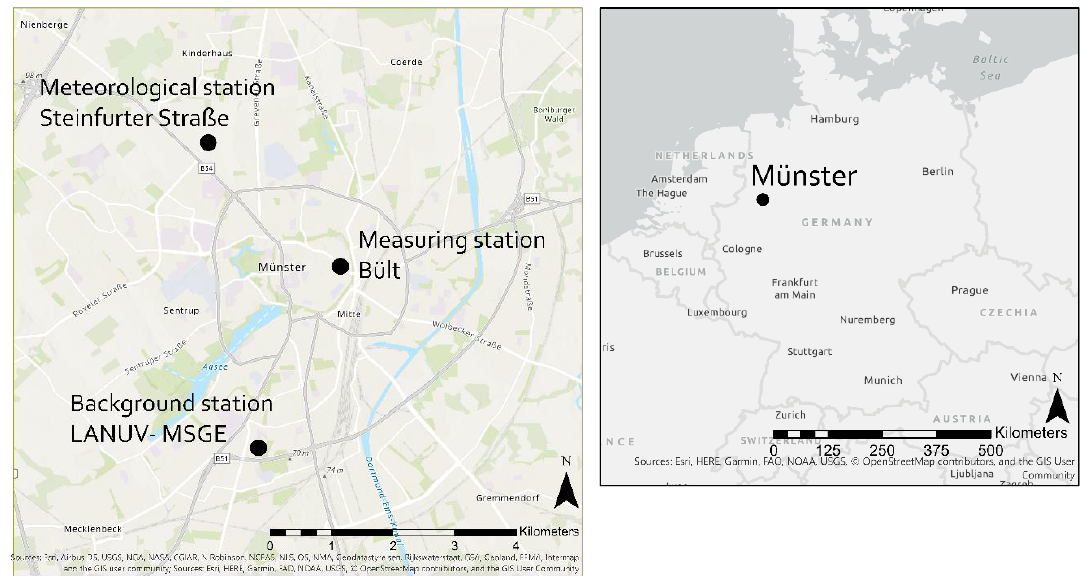
Figure 1. The location of Münster in Germany ( left ) and the three measurement stations within Münster ( right ).